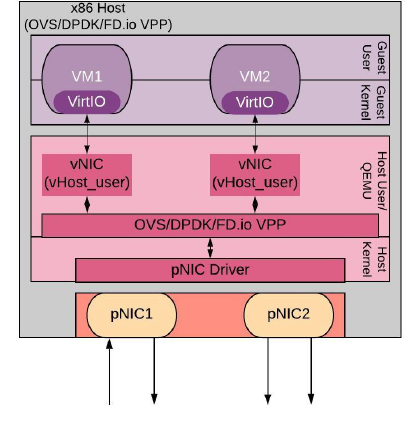
Figure 1. Non SR-IOV Architecture.